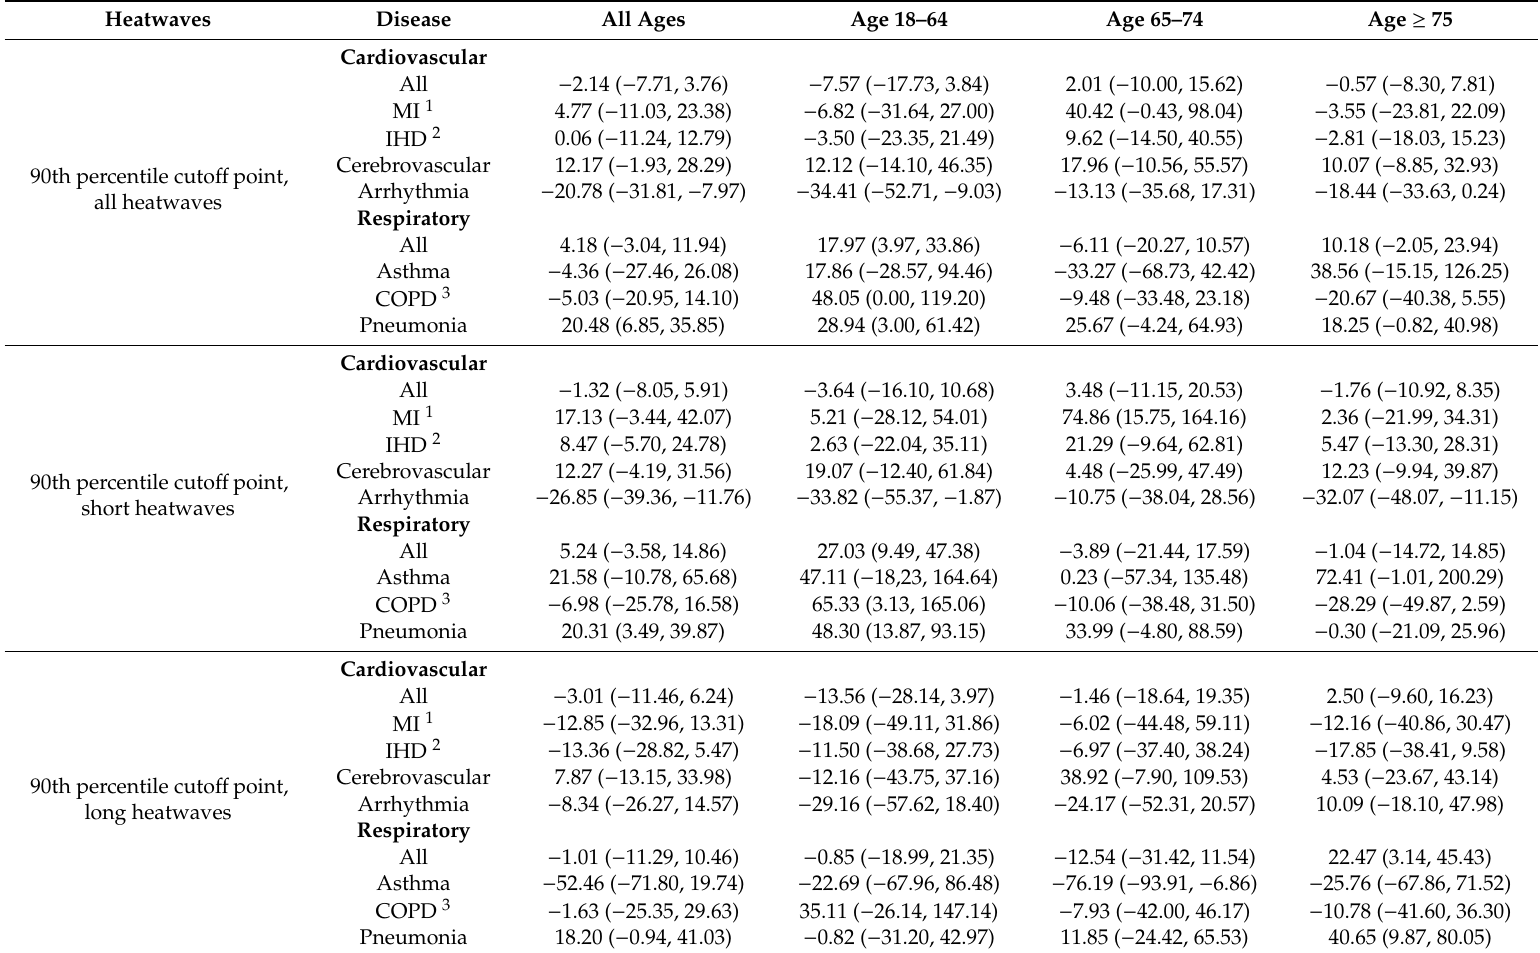
Table 5. Percentage change (95% CI) in daily hospital admissions for cardiorespiratory diseases associated with heatwave days in summer months (June–August) in the Helsinki metropolitan area, Finland,